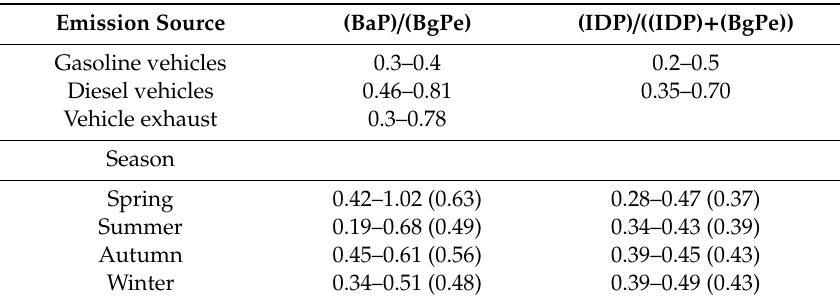
Table 2. Concentration ratios of PAHs and